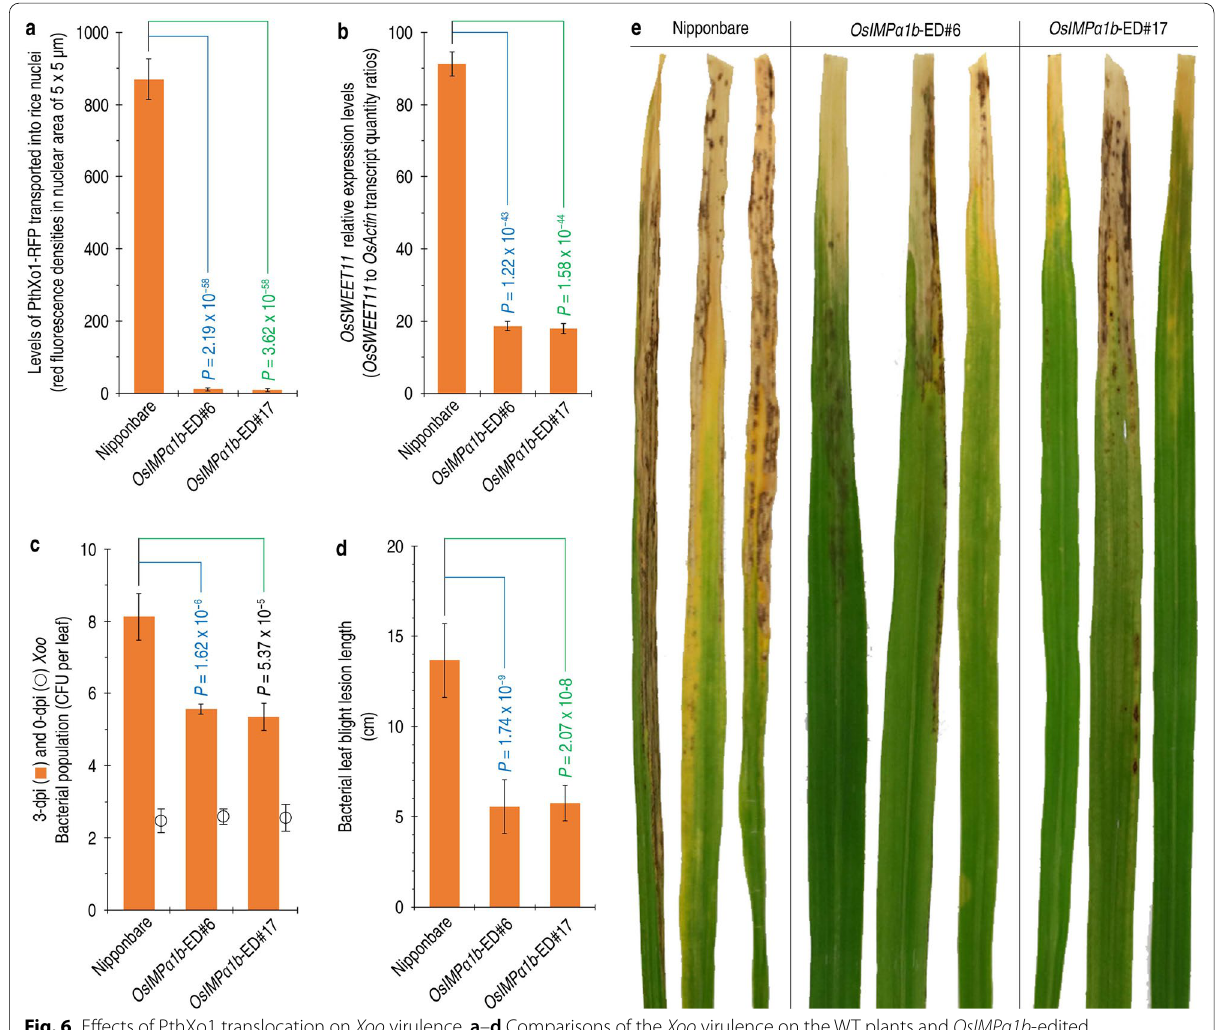
Fig. 6 Effects of PthXo1 translocation on Xoo virulence. a – d Comparisons of the Xoo virulence on the WT plants and OsIMPα1b -edited ( OsIMPα1b -ED) mutants. PthXo1 translocation at 9 h post-inoculation (hpi) ( a ), expression of the PthXo1-targeted OsSWEET11 gene at 24 hpi ( b ), in planta bacterial populations at 0 and 72 hpi ( c ), and disease severity at 14 days post-inoculation (dpi) ( d ) were determined correspondingly. The data shown are mean values SDs ( n 3). The P values are from two-sided unpaired Student’s t tests ( P < 0.01). e Fragments of Xoo -inoculated ± = leaves imaged at 10 dpi. The leaf images are representative of 30 leaves of 15 plants tested in 3 experimental replications per genotype (WT, OsIMPα1b -ED#6, or OsIMPα1b